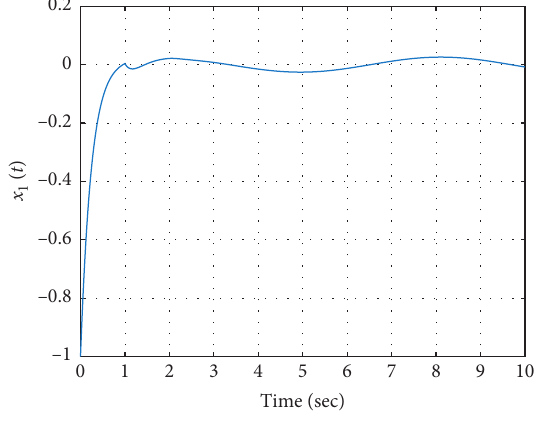
Figure 4: Control input u ( t )